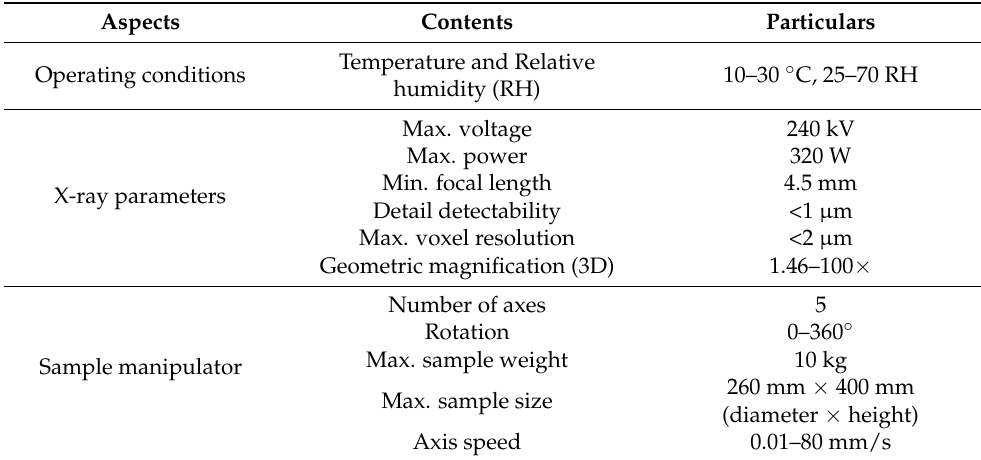
Table 3. Controlling parameters of X-ray inspection system v|tome|x s